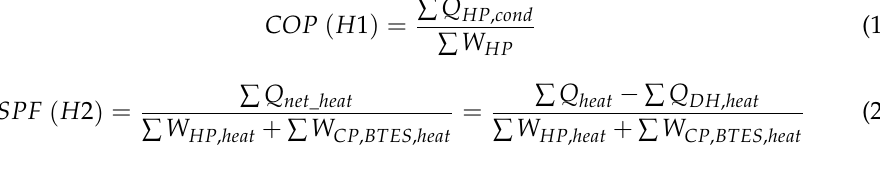
Table 1. Nomenclature of thermal energy meters in Aalto New Campus Complex (ANCC). Zone/Type ARTS + BIZ